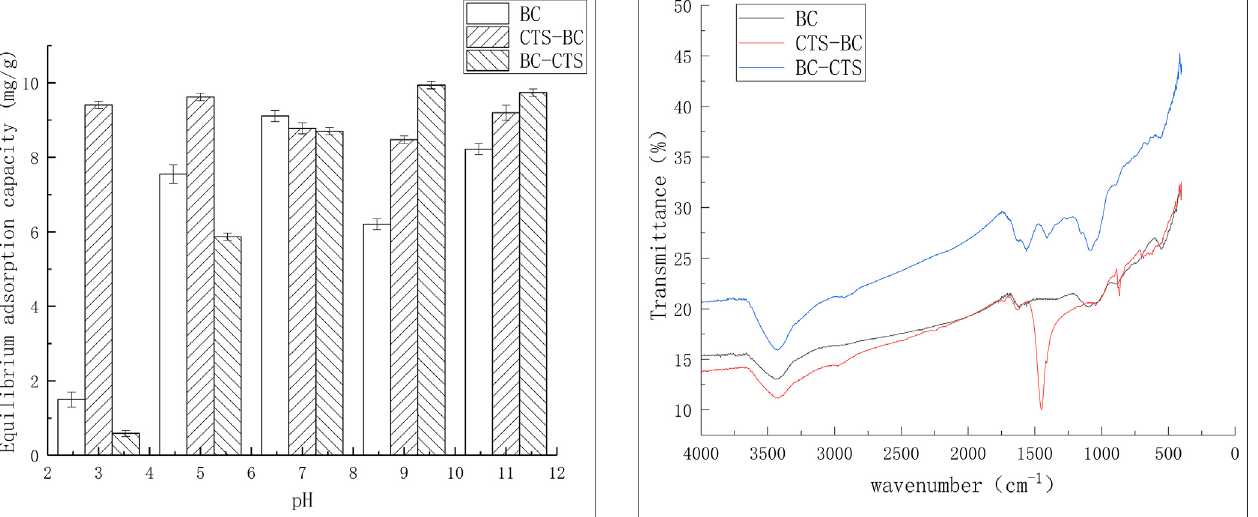
FIGURE7| EquilibriumadsorptioncapacityoftheBC,CTS-BC,andBC- CTS under different pH conditions.